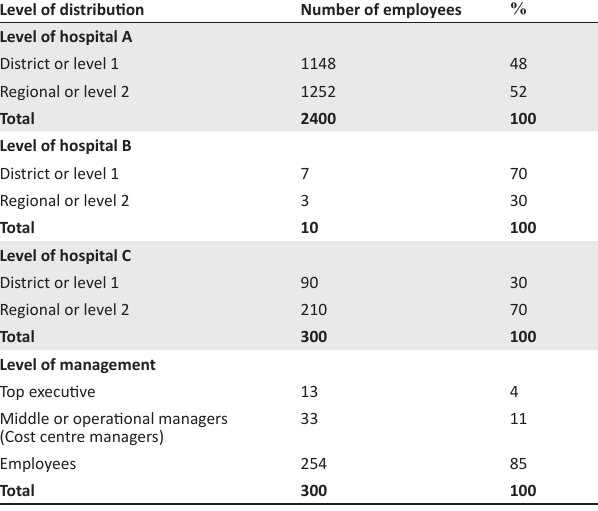
TABLE 3: Distribution according to number of